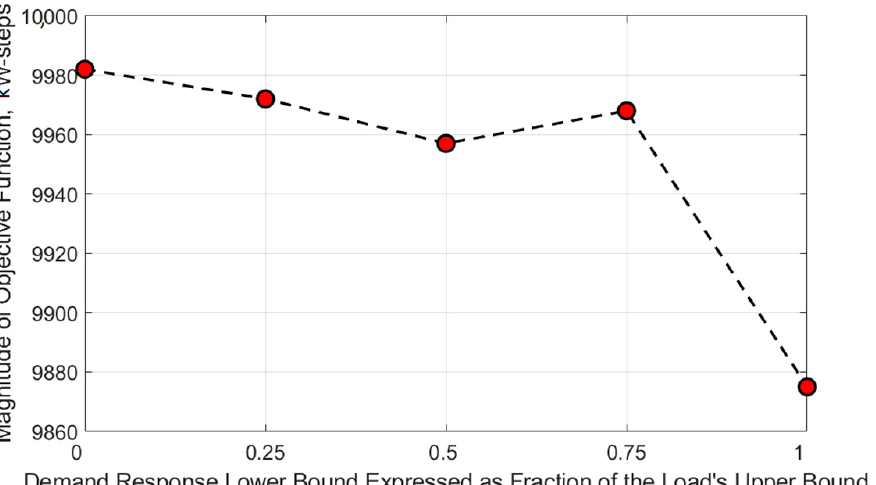
Figure 7. Effects of Demand Response on the Objective Magnitude (Restored Energy).